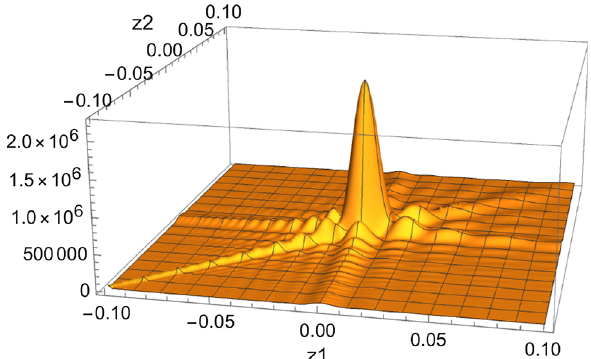
, z ) | 2 against 1 2